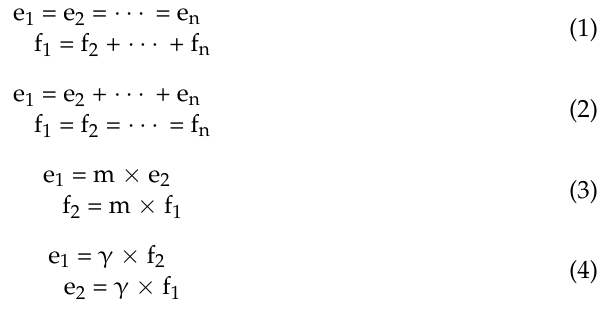
Figure 1. Junctions used in this paper. (a) 0-junction. (b) 1-junction. (c) Two-port transformer. (d) 100 Two-port gyrator.